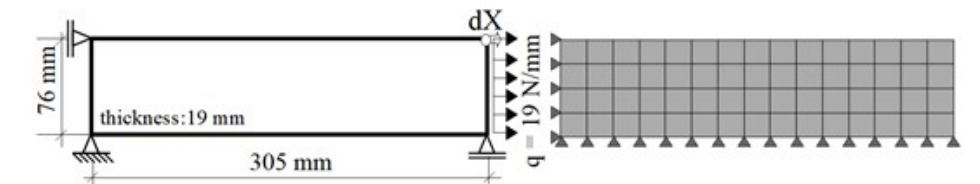
Figure 8. Direct tension simulation - geometry and